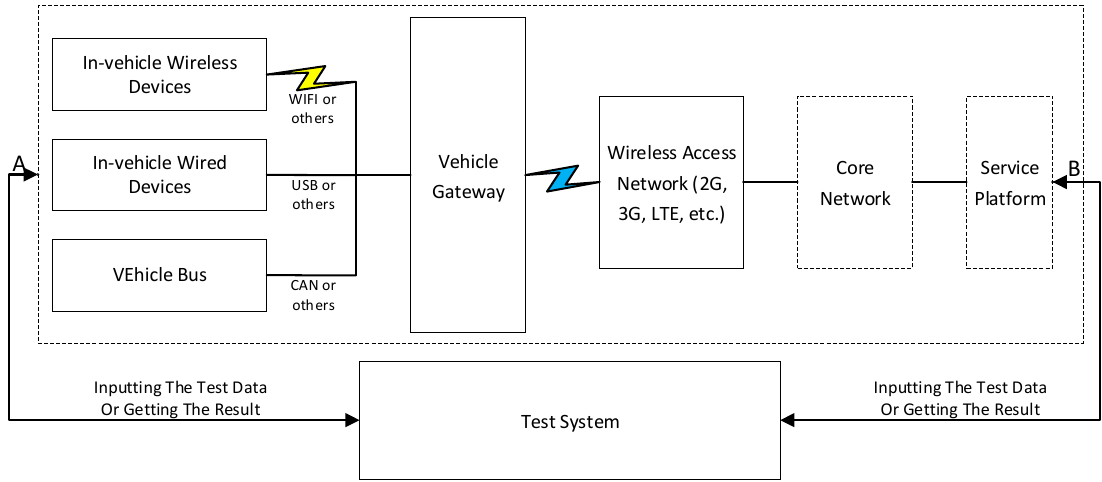
Figure 7. Vehicle Gateway Testing Architecture.